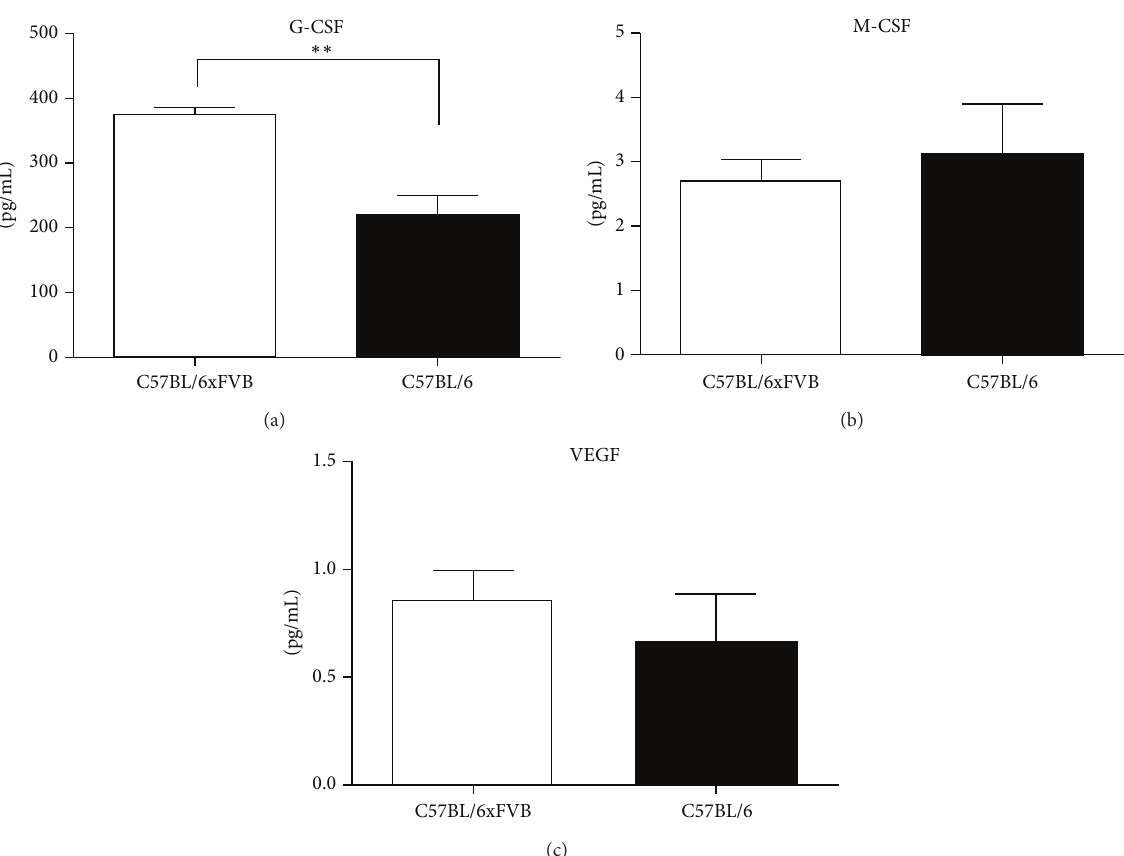
Figure 1: Concentrations of growth factors in serum. G-CSF concentration was higher in C57BL/6JxFVB than in C57BL/6J mice. There were no differences in concentrations of M-CSF and VEGF.